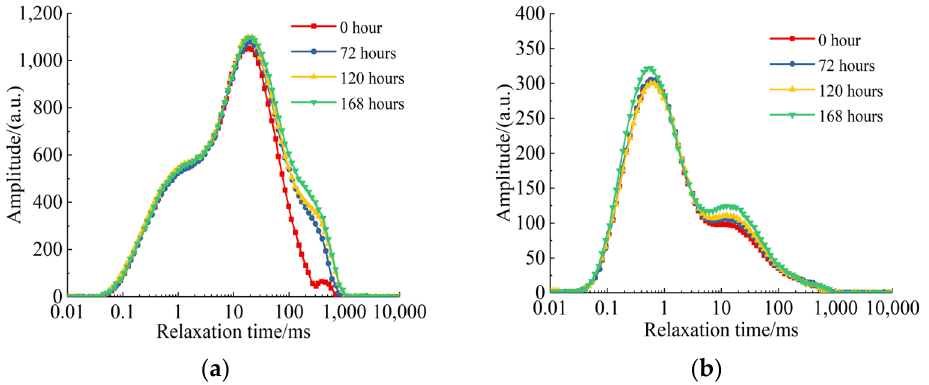
Figure 12. NMR of tight sandstone cores for fluid dynamics analysis. ( a ) Core L54–350–5; ( b ) core Q1–10.